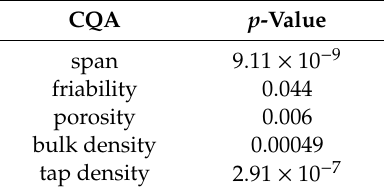
Table 5. p -values, describing the e ff ect of milling on various CQA’s. CQA p